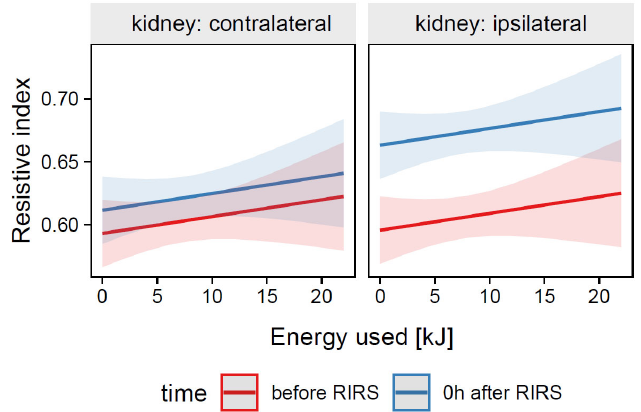
Figure 3. Predicted values (marginal e ff ects) of resistive index by the Mod2 regression model for energy used, time, and kidney side terms.